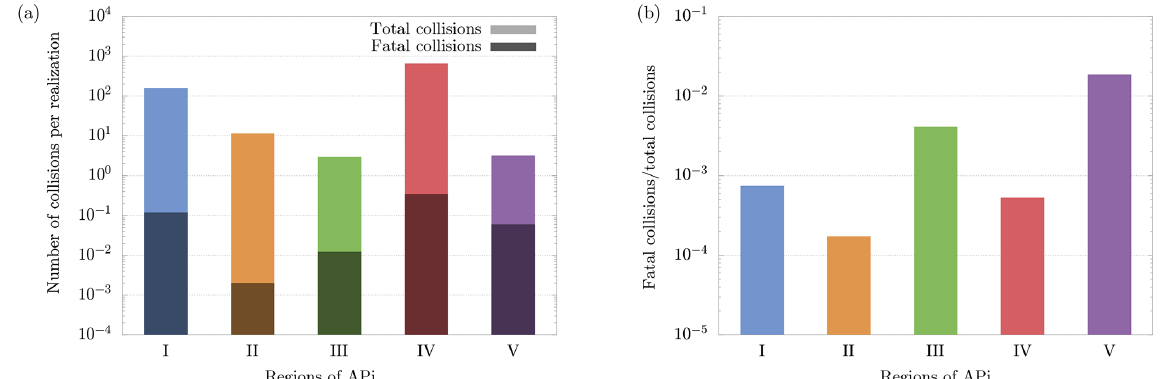
)( H 2 SO 4 )( HOM 10 ) cluster dynamics. Notice that 4